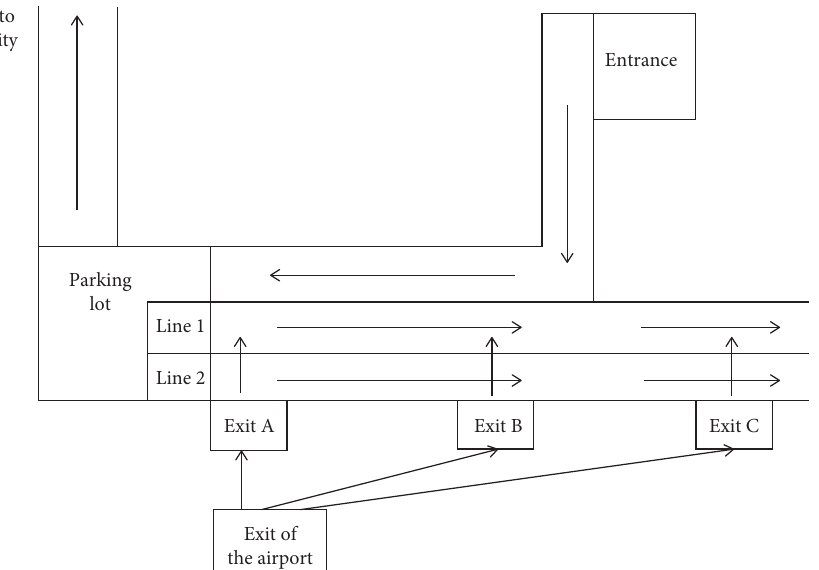
Figure 7: Simulation map of airport boarding area.